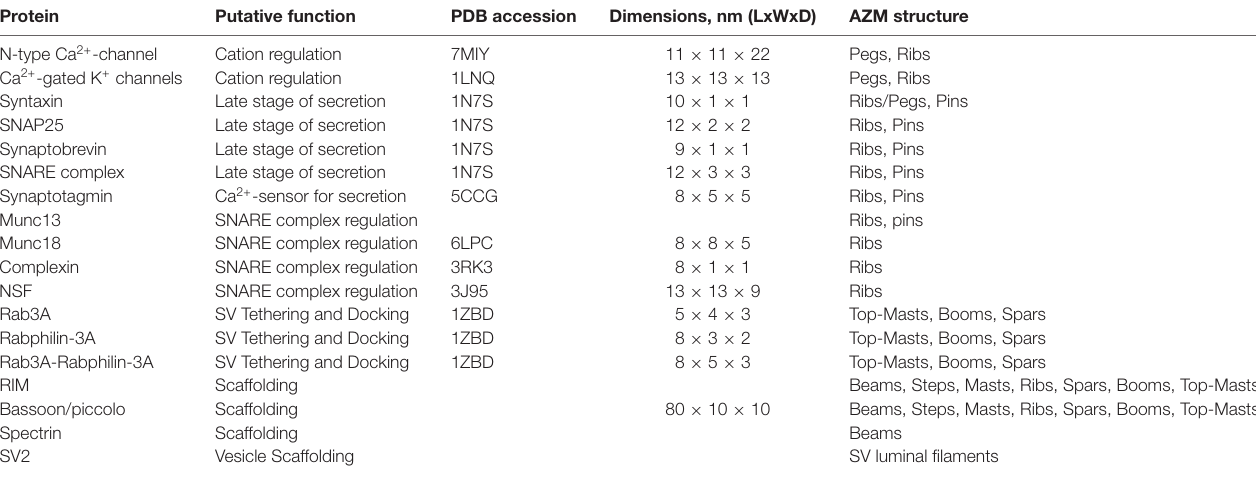
TABLE 2 | Hypothesis of protein contributions to the classes of AZM macromolecules. Protein Putative